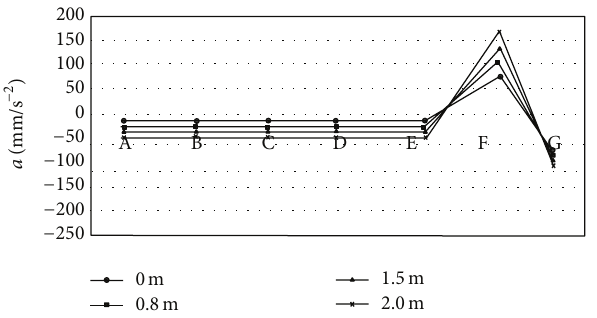
Figure 9: 𝑌 -direction acceleration diagram.